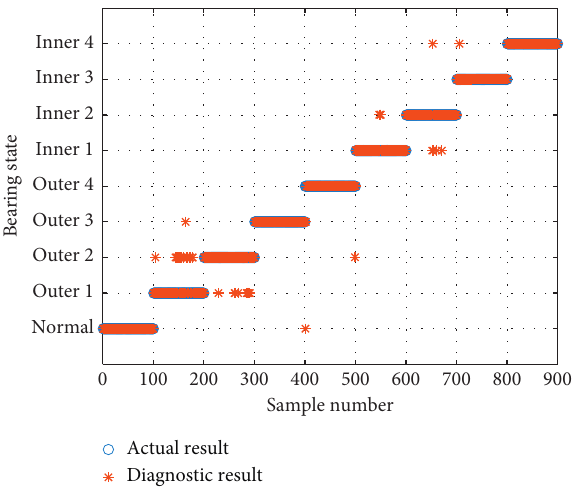
Figure 20: Degradation identification results of variable speed samples.